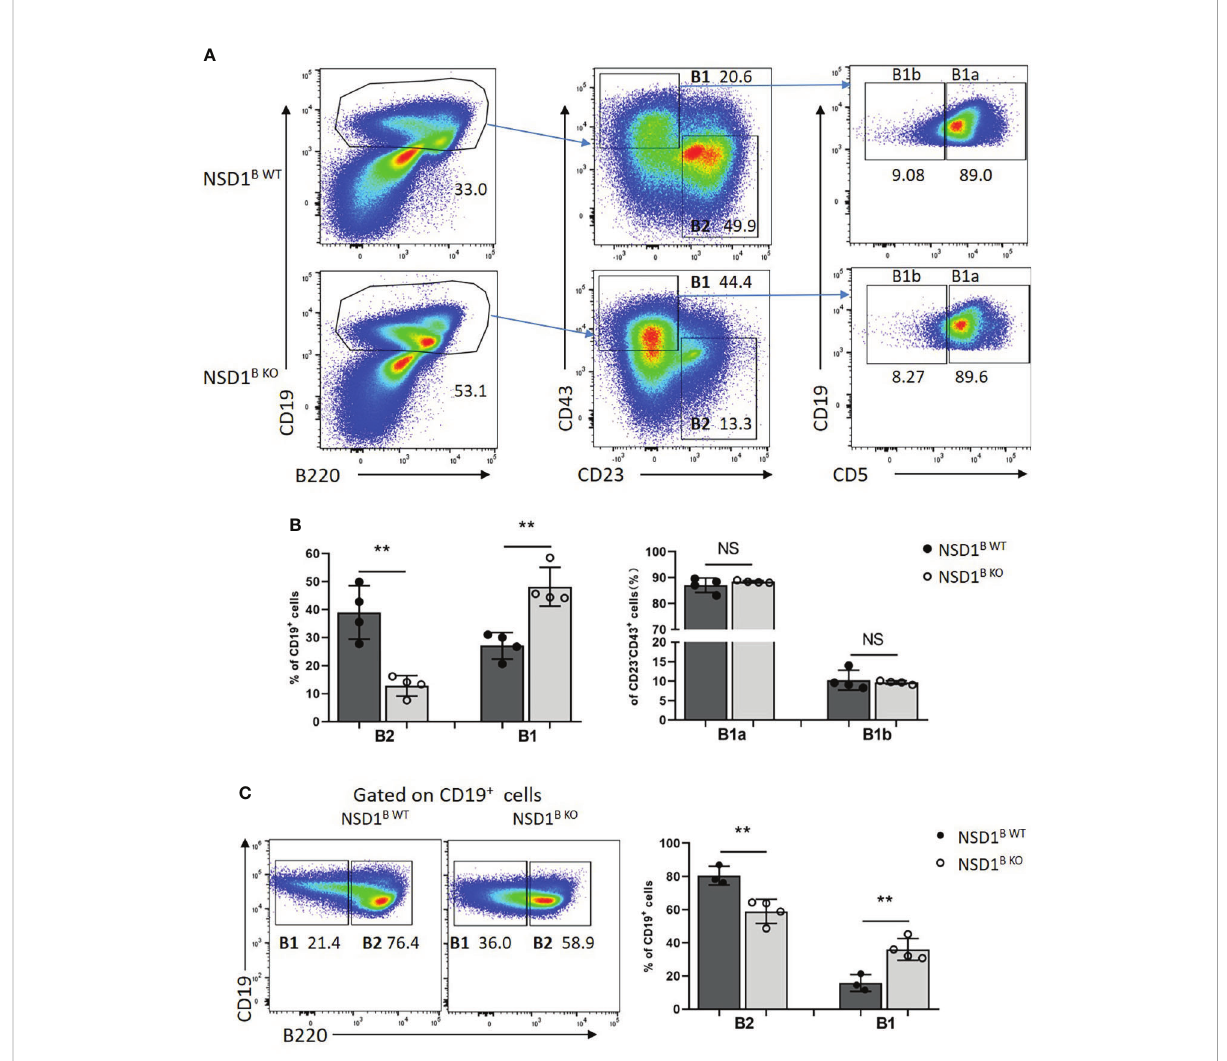
FIGURE 5 Loss of NSD1 increased the development of B1 cells in peritoneal cavity (A, B) . The distribution of B1 (CD19 + CD43 + CD23 - ), B2 (CD19 + CD43 - CD23 + ) cells, B1a (CD19 + CD43 + CD23 - CD5 + ) and B1b (CD19 + CD43 + CD23 - CD5 - ) in the peritoneal cavity from NSD1 B WT and NSD1 B KO mice. (B) . The distribution of B1 (CD19 + B220 - ) and B2 (CD19 + B220 + ) cells in the peritoneal cavity from NSD1 B WT and NSD1 B KO mice. (n = 3 or 4). ** P < 0.01. NS, no signi fi cant